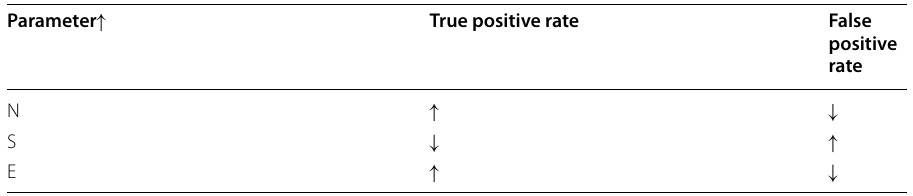
Table 4 Summary of experimental